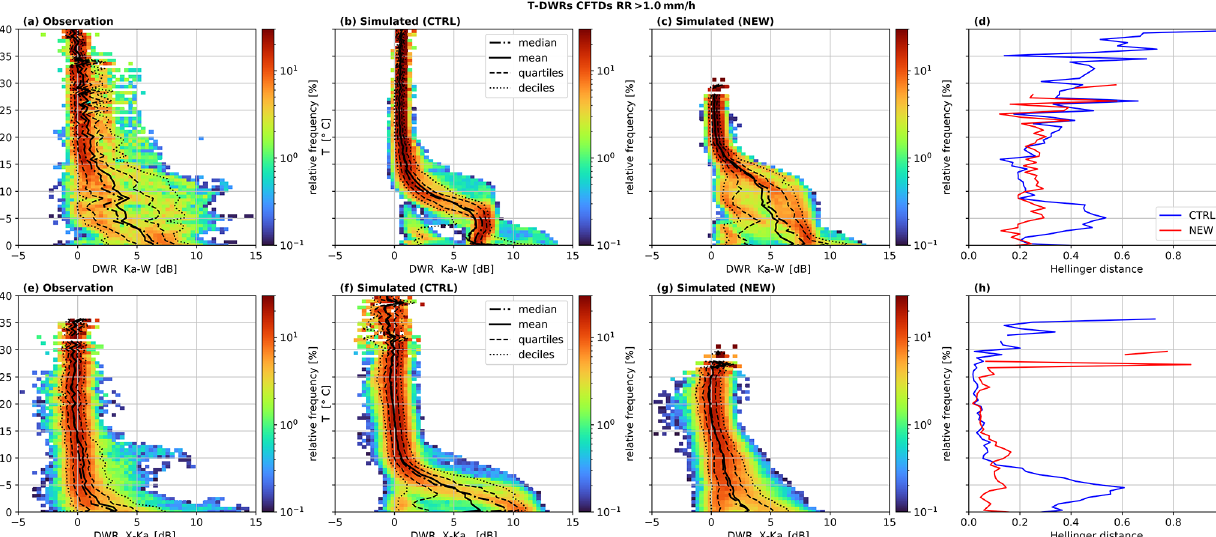
Figure 11. Contour frequency by temperature diagrams (CFTDs) for all profiles with RR > 1mmh − 1 of the dual-wavelength ratios between the X and Ka band (DWR X,Ka , top) and between the Ka and W band (DWR X,Ka , bottom) from the default simulation (a, e) , the new simulation (colMix2_Akernel; b and f ), and measured (c, g) . The black lines represent the statistical measures (median, mean, quartiles, and deciles) at different temperatures. Panels (d) and (h) show the Hellinger distance between the simulated and observed distributions for all